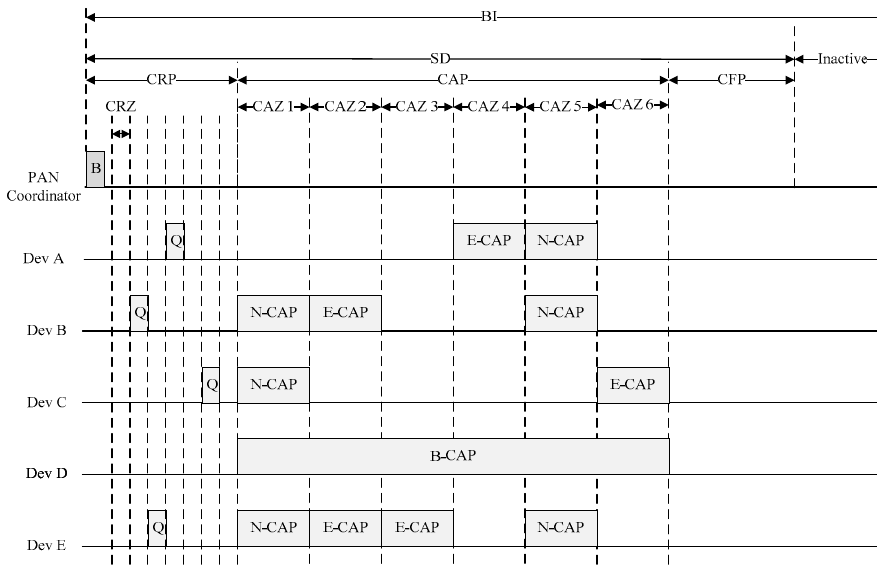
Figure 6. The procedure of data transmission in the proposed scheme.